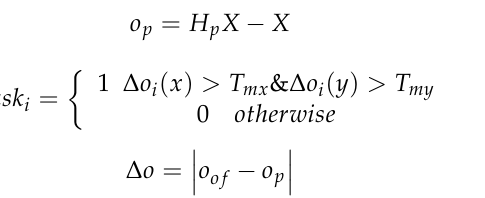
ments of the feature-based method, the abnormal displacements of BOF are adaptively detected by a given threshold. Concretely, the feature points are extracted by SIFT. The relationship between the reference and the sensed image assumes to be described by the GP model H p . Then the pixel-wise displacement o p is generated by Equation (5) and the mask for abnormal displacement is obtained in Equation (6).